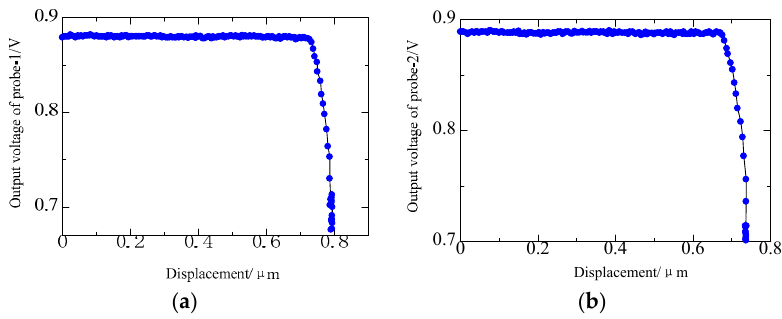
Figure 10. Approaching curves: ( a ) Approaching curve of probe-1; ( b ) Approaching curve of probe-2.